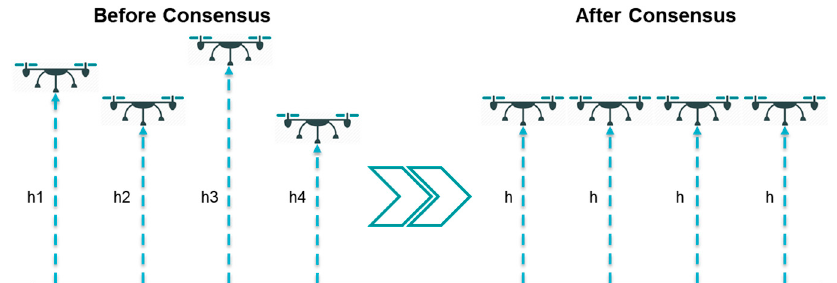
Figure 1. Consensus problem.